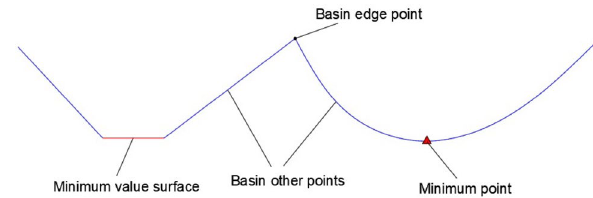
Figure 7. 2D topographic image of watershed.